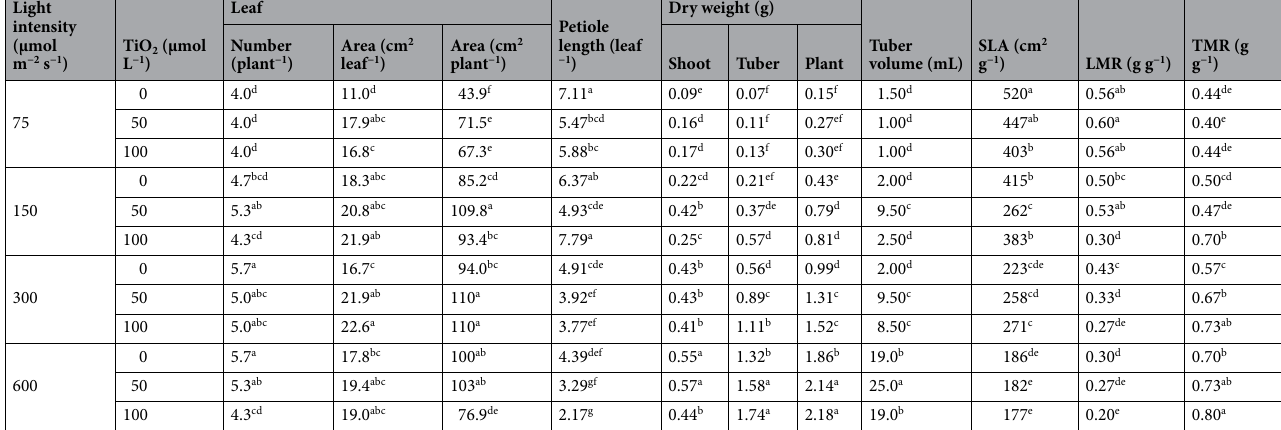
Table 1. Effect of cultivation light intensity and spray treatment (once a week, and three times in total) with titanium dioxide (TiO 2 ) nanoparticles on growth and morphology of radish cv. Cherry belle plants. Six replicate plants were assessed per treatment. In traits, where the interaction of the two factors (light intensity, TiO 2 nanoparticle concentration) was significant, different letters indicate significant differences. LMR leaf mass ratio, SLA specific leaf area, TMR tuber mass